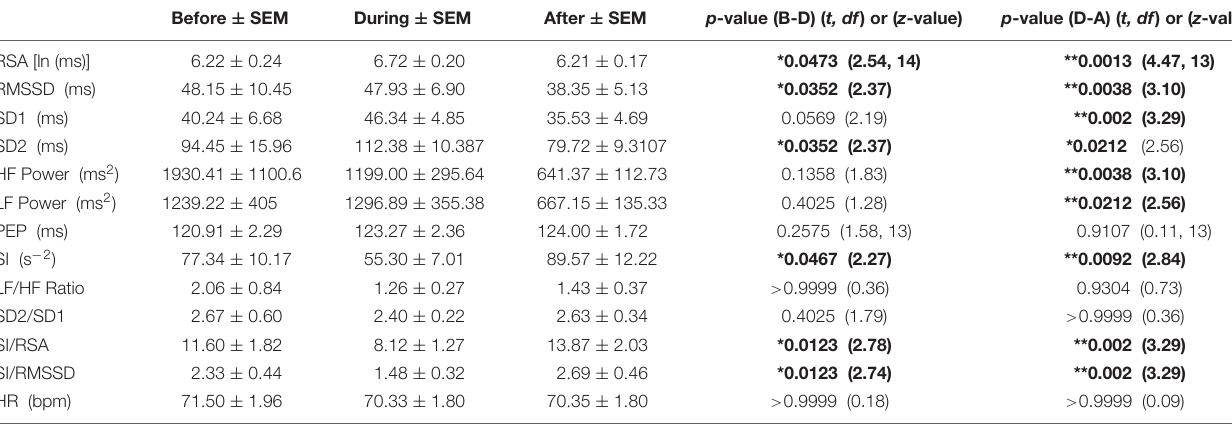
TABLE 3A | HRV parameters associated with HAPWs in response to the meal ( n = 16).